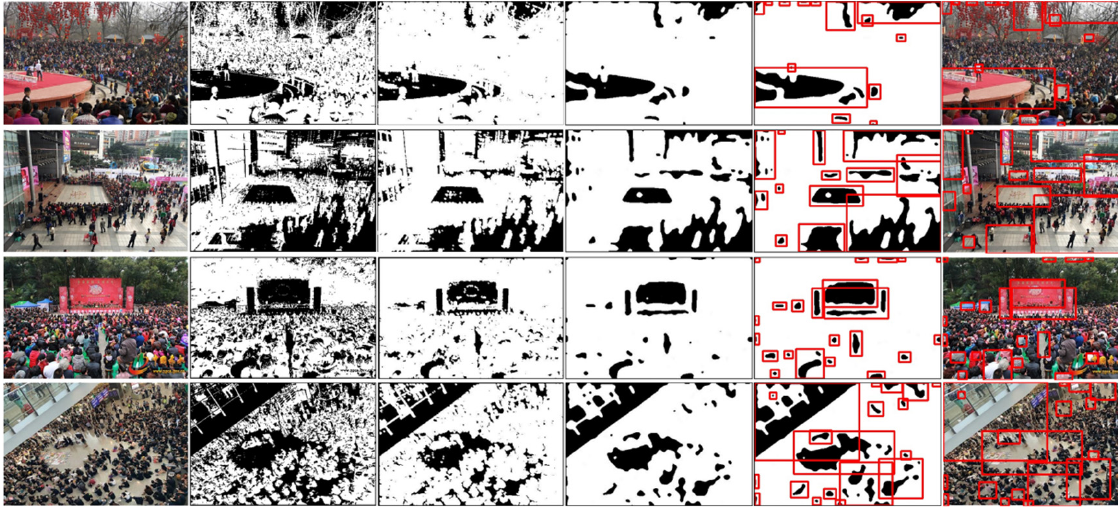
Figure 4. Some examples after the candidate important areas generation process.